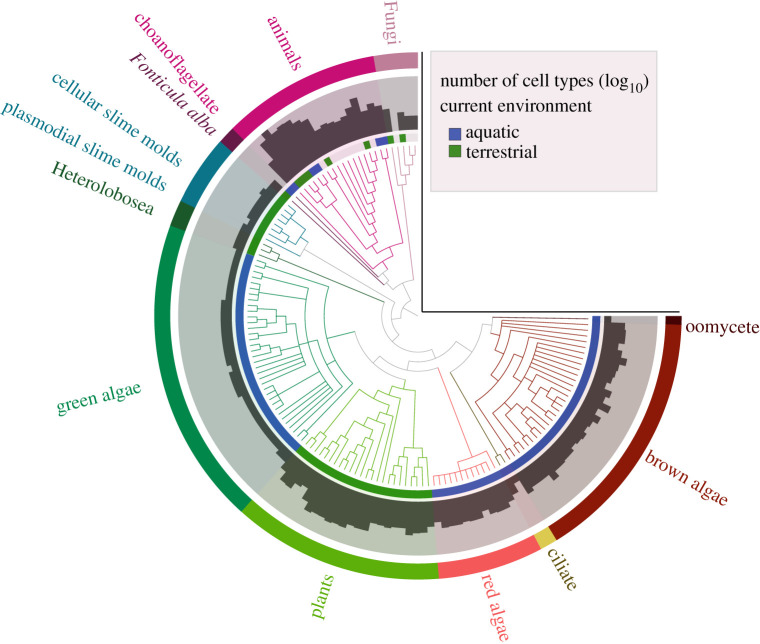
Phylogeny of the multicellular lineages in our dataset. Each lineage that independently evolved multicellularity within the eukaryotes is highlighted in a different colour—with two independent lineages within the ciliates (N = 14). The number of cell types (log10) from 1 – more than 102.3 cell types are shown on the bar plots around the circumference of the phylogeny, and the current environment of each species (blue = aquatic, green = terrestrial) are also shown. The phylogeny was created using Anvi (anvi-server.org).